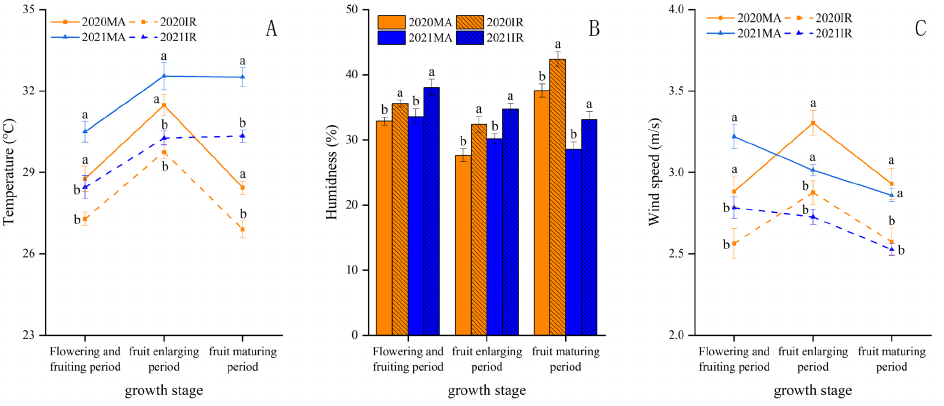
Figure 5. Schematic diagram of temperature, humidness, and wind speed changes in different stages of monocropping apple and ryegrass apple intercropping system. (( A ): temperature; ( B ): humidness; ( C ): wind speed, Different lowercase letters in the graph indicates significant differences across treatments ( p < 0.05).).